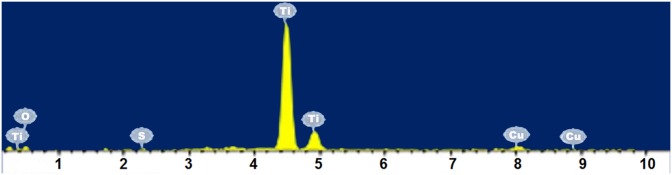
EDX spectrum of CuS-GeO2-TiO2 composite coating.